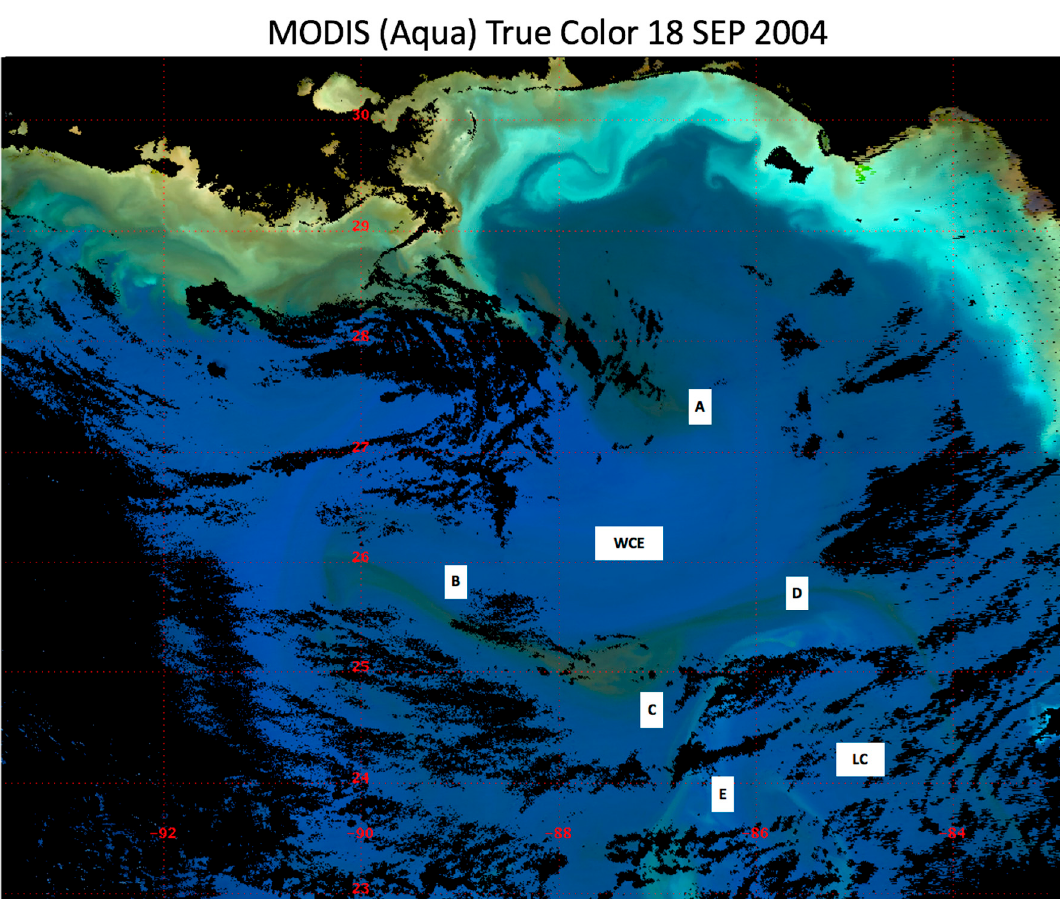
Figure 12. MODIS (Aqua) True Color (colorimetry method) corresponding to Figures 10 and 11. Labeled areas are as in Figures 10 and 11.